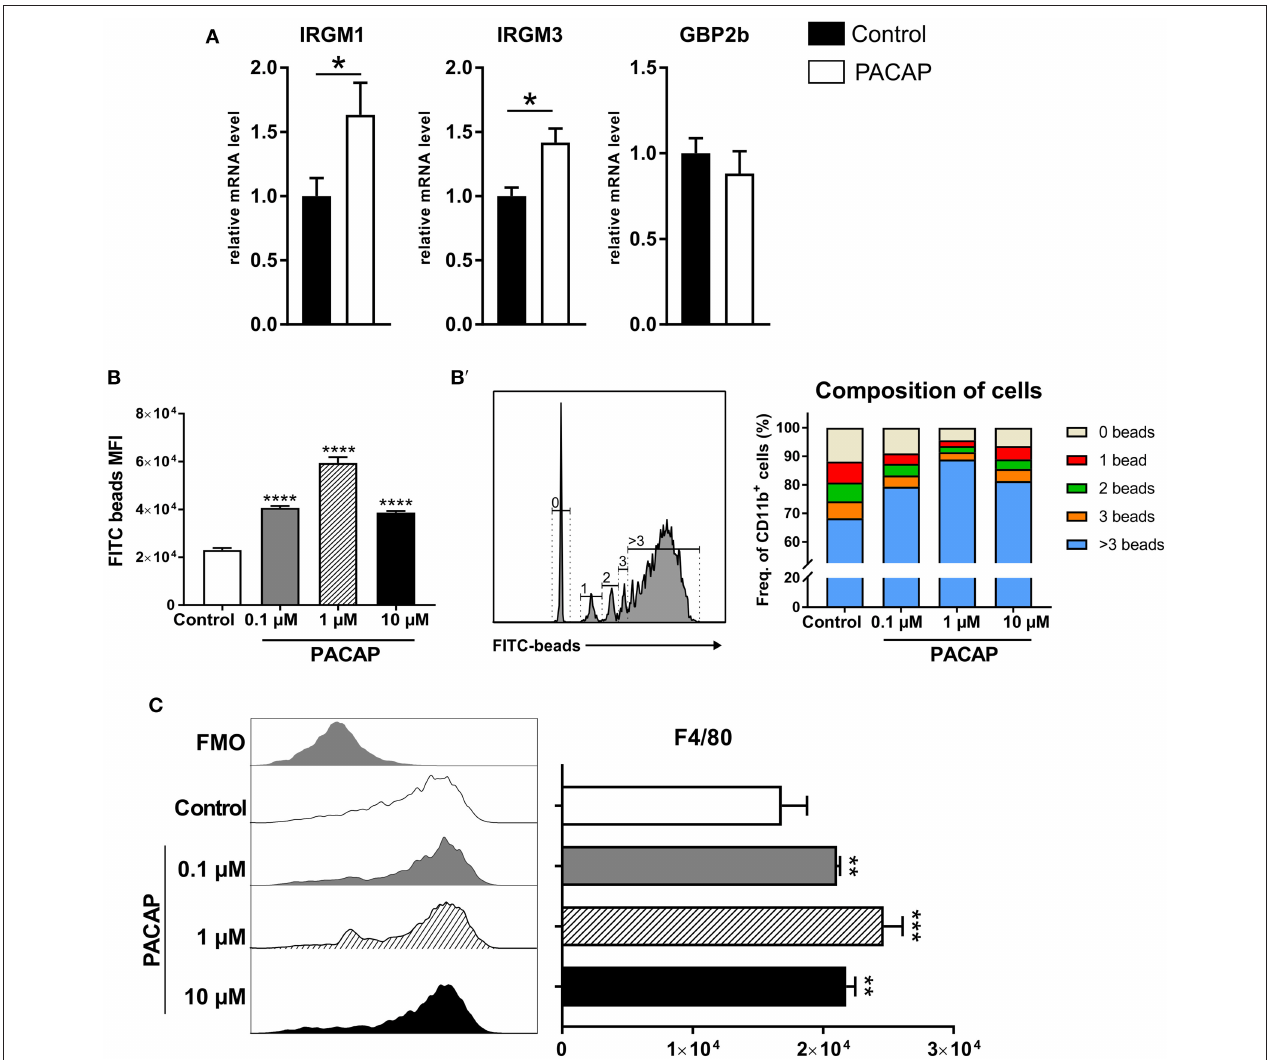
FIGURE 3 | PACAP treatment increases expression of host-defense factors and phagocytosis. (A) Bar charts show gene expression of IRGs and GBP2b associated with parasite elimination in peritoneal exudate cells assessed by RT-qPCR. The gene expression levels of host defense factors were determined by RT-qPCR using Hprt as reference gene. Data were further normalized to mean values of control group; Control (black bars) and PACAP-treated (white bars). Bar charts present results as mean ± SEM, n = 4; * p < 0.05 (two-tailed unpaired t -test). (B) Phagocytosis of BMDMs primed to M1 phenotype was assessed by incubation with FITC-fluorescent microspheres in the presence of different PACAP concentrations (0.1, 1, and 10 µ M); phagocytic capability was evaluated by the MFI of the positive populations. (B’) Histograms and bar charts show frequency cells fractioned according to the amount of microspheres internalized. (C) Histograms and bar charts show activation marker F4/80 expressed on BMDMS in the phagocytosis assay. Data are expressed as mean ± SEM (one-way ANOVA with post-hoc Holm-Sidak